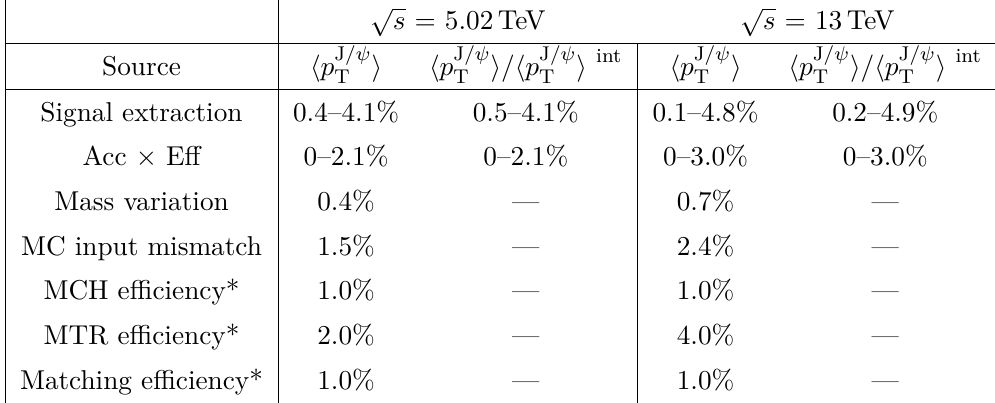
i measurements. Values marked T